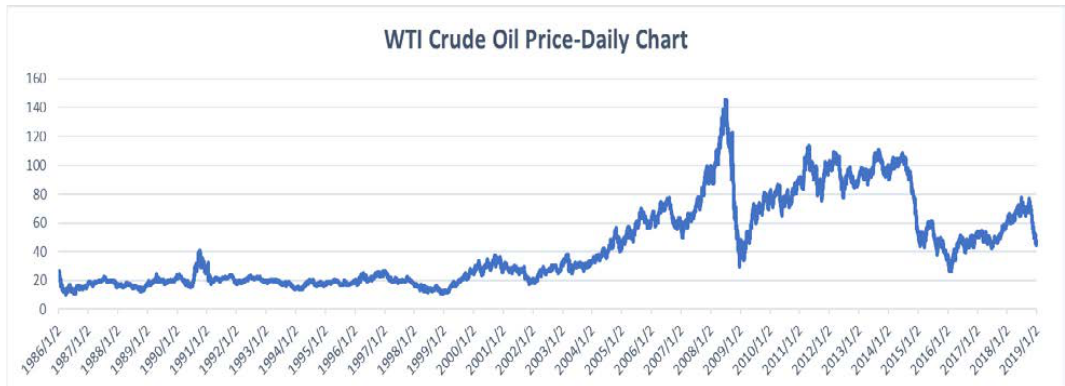
Figure 6. The daily chart of WTI crude oil prices from 2 January 1986 to 3 January 2019.